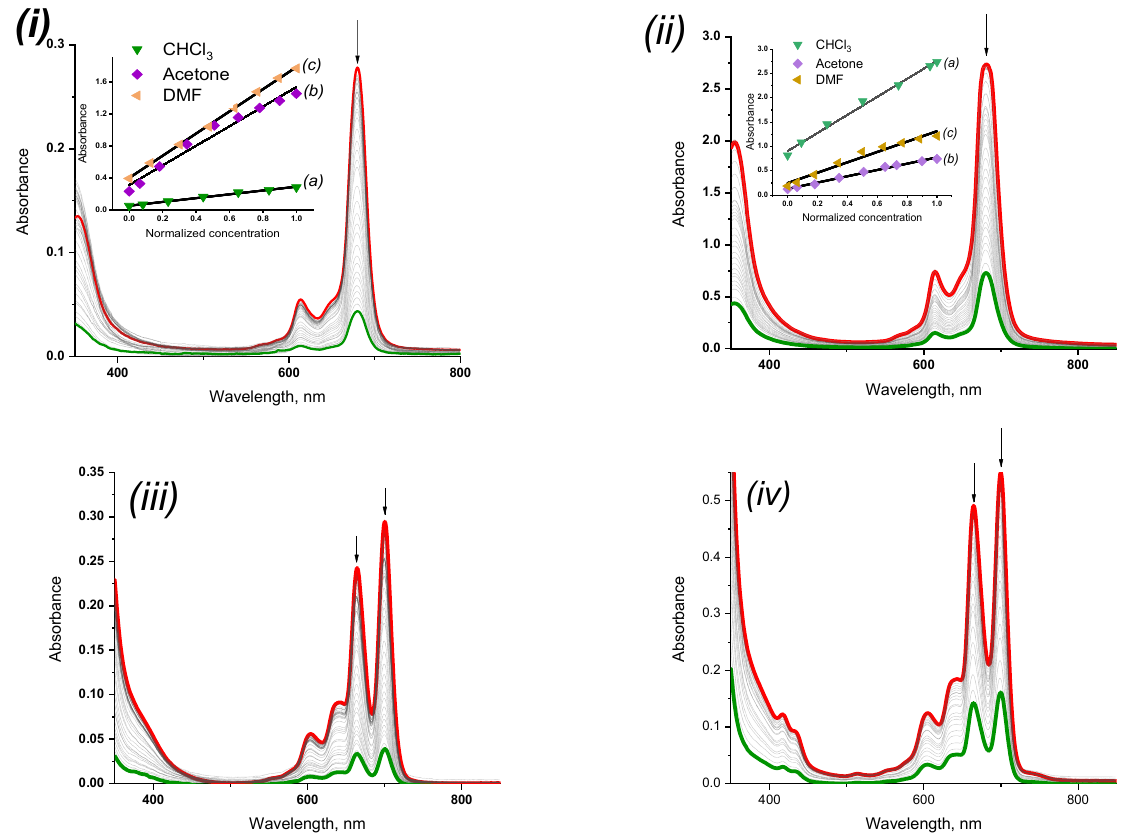
Figure 2. Changes in UV-vis spectra of compound 4 ( i ), 5 ( ii ), 6 ( iii ), and 7 ( iv ) solutions in CHCl 3 upon dilution at concentration range of 5.46 × 10 − 5 mol/L to 1.17 × 10 − 5 mol/L. Insertion: the Lambert-Buger-Beer dependences in chloroform ( a ), acetone ( b ), and dimethylformamide ( c ) (red curve—initial spectrum; green curve—final spectrum). Note: spectra for compounds in acetone and DMF are provided in Supplementary Materials).